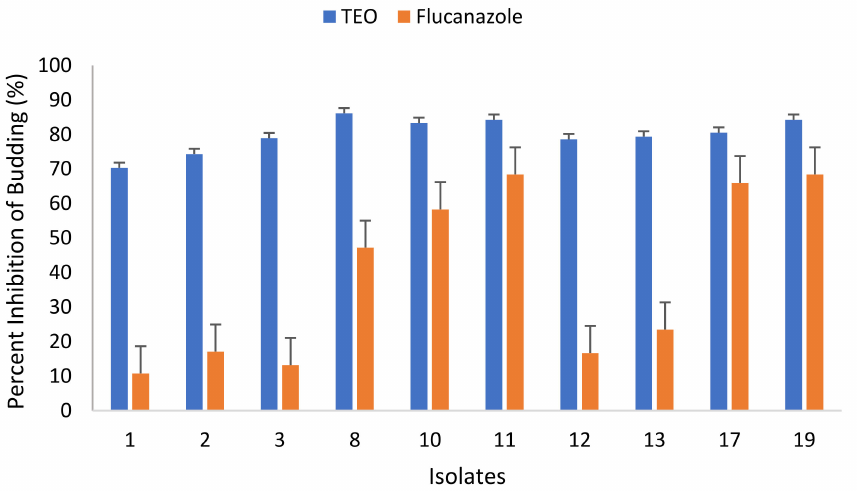
Figure 5. Percent inhibition of budding formation of C. albicans incubated at sub-inhibitory concen- trations (1/2 × MIC) of the Thyme essential oil (TEO).